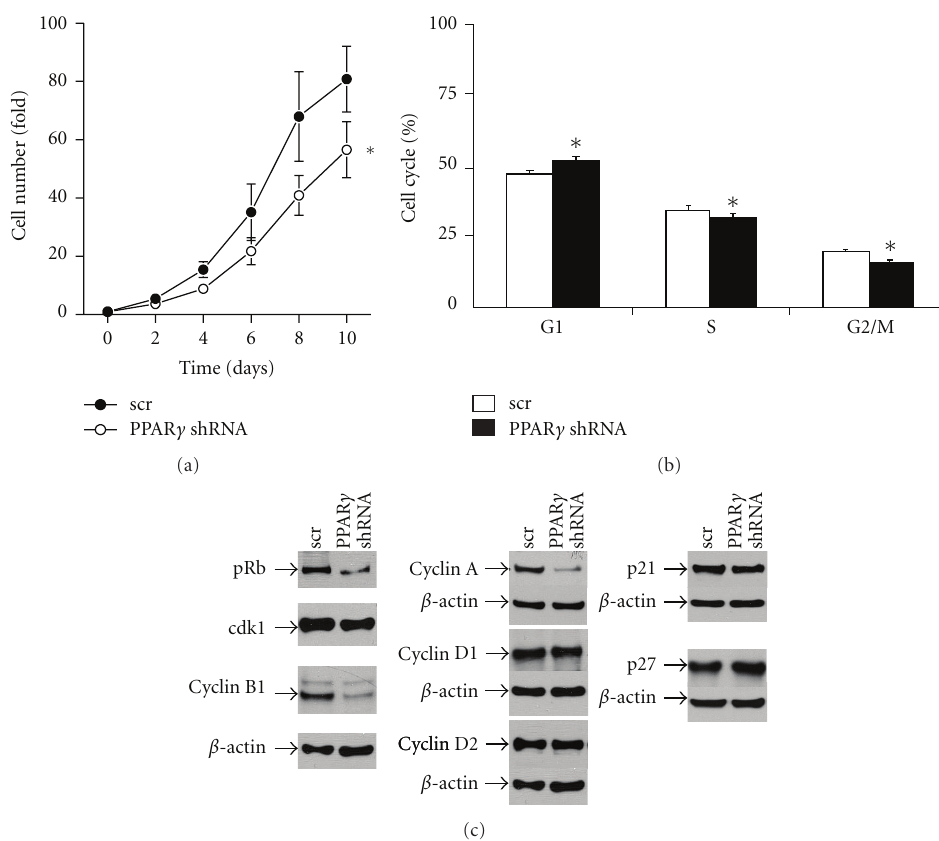
Figure 4: E ff ect of PPAR γ knockdown on the growth characteristics of HTh74 cells. (a) Cell growth rate was assessed by counting viable cells transduced with scrambled (scr) or PPAR γ shRNA at 2-day intervals. Data is represented as fold cell number over day 0 (6 expts. ± SEM, ∗ , P = 0 . 04, 2-way ANOVA calculated over the entire growth curve). (b) scr-(white bars) and PPAR γ shRNA-(black bars) transduced HTh74 cells were growth arrested in 0.5% FBS for 24h and analyzed by flow cytometry 24h following subsequent growth in 5% FBS. Flow data (3 expts.) was quantitated for % of cells in G1, S, and G2/M phases as shown ( ∗ , G1- P < 0 . 001; S, P = 0 . 04; G2/M, P < 0 . 001: paired t -test). (c) 50 μ g of total cellular protein from HTh74 cells transduced with either scrambled or PPAR γ -specific shRNA was separated on a 10% SDS-PAGE gel, transferred to PVD, and probed with antibodies against the corresponding cell cycle protein whose source is described in Section 2.4 followed by the appropriate secondary antibody. β -actin was quantitated as a loading control.